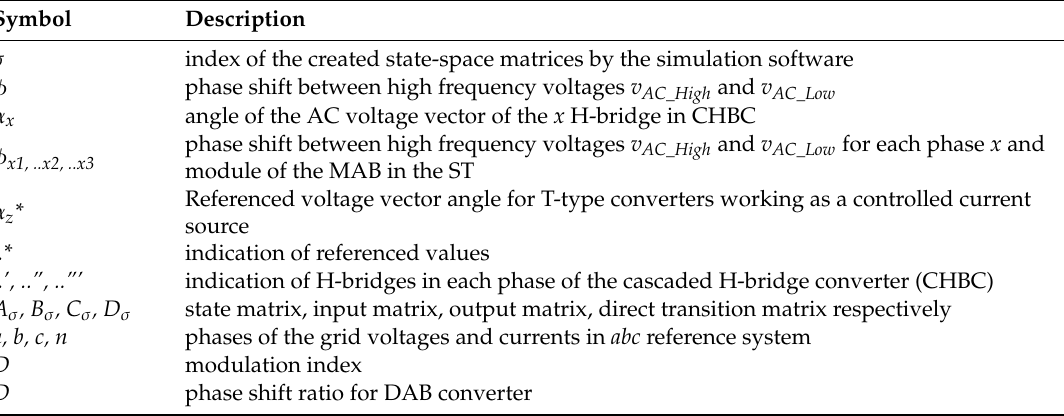
Table A1. List of